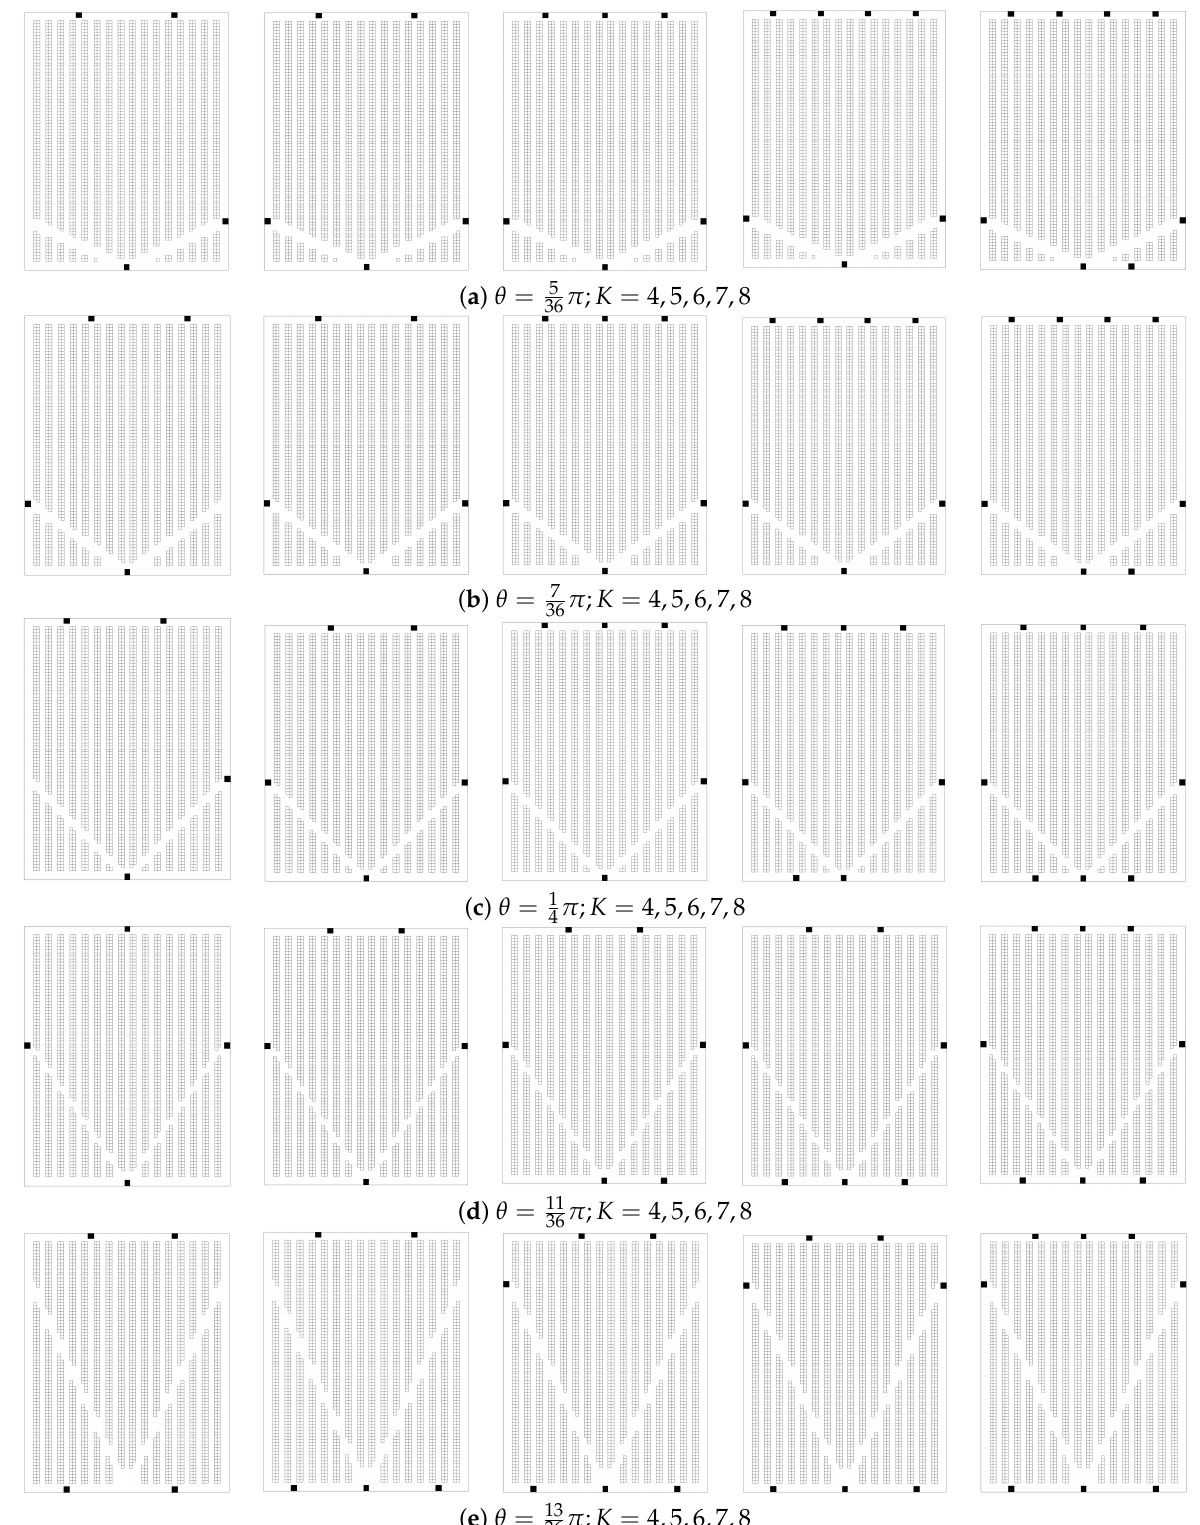
Figure A4. Optimal workstation layout in flying-V warehouses with various angles ( N = 32; L =